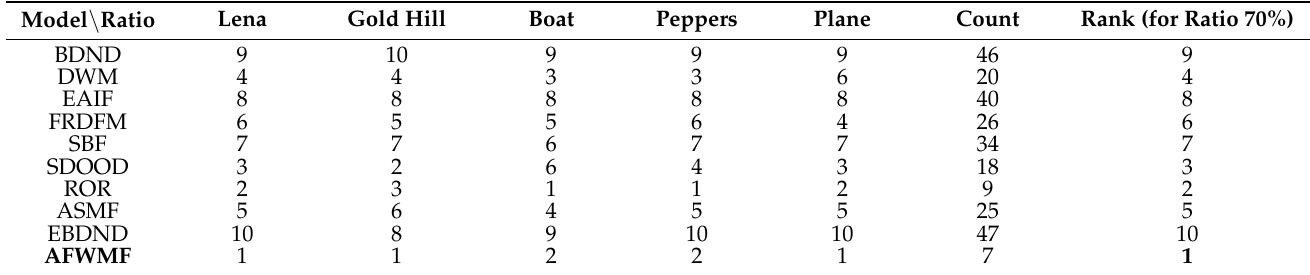
Table 9. The ranking of the 10 filter models according to the three experts’ average evaluations at 70% noise density for the five experimental